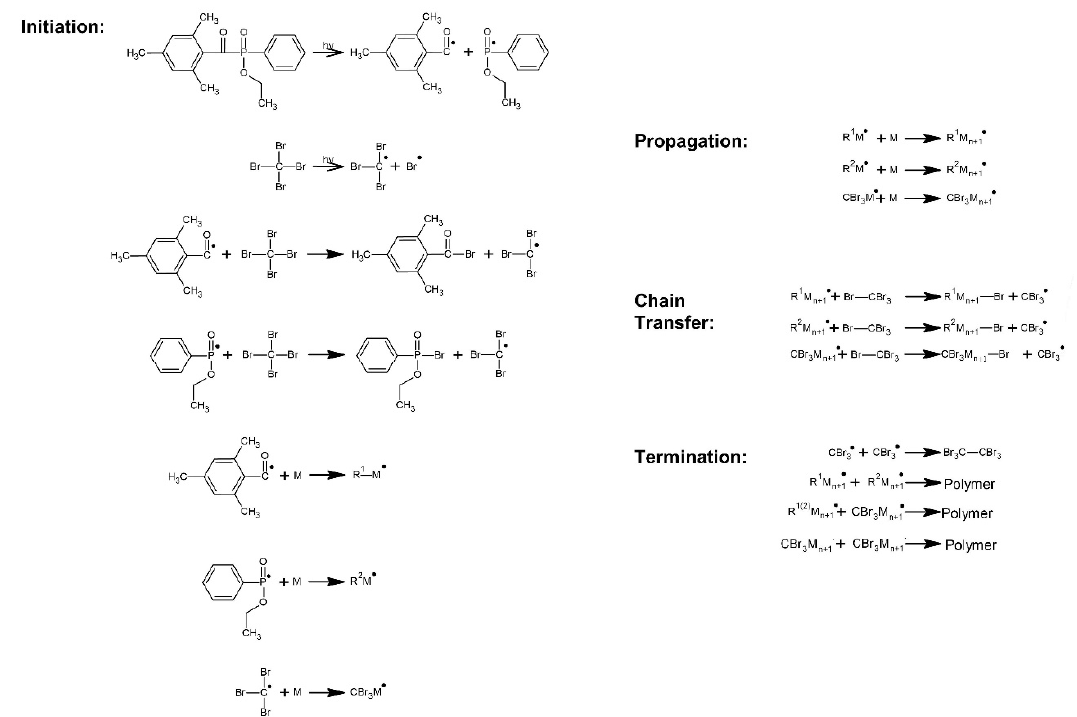
Figure 1. Schematic graph of the UV-induced cotelomerization process.